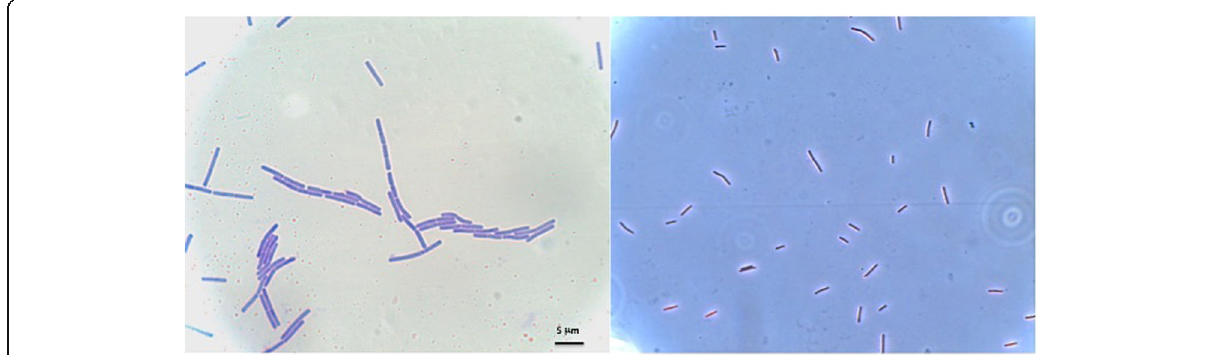
Table 1 Classification and general features of Bacillus velezensis strain 2A-2B [37] MIGS ID Property Term Evidence code a Classification Domain: Bacteria TAS [38] Phylum: Firmicutes TAS [39, 40] Class: Bacilli TAS [41] Order: Bacillales TAS [42] Family: Bacillaceae TAS [43] Genus: Bacillus TAS [44] Species Bacillus velezensis TAS [37] Strain: 2A-2B Positive IDA IDA